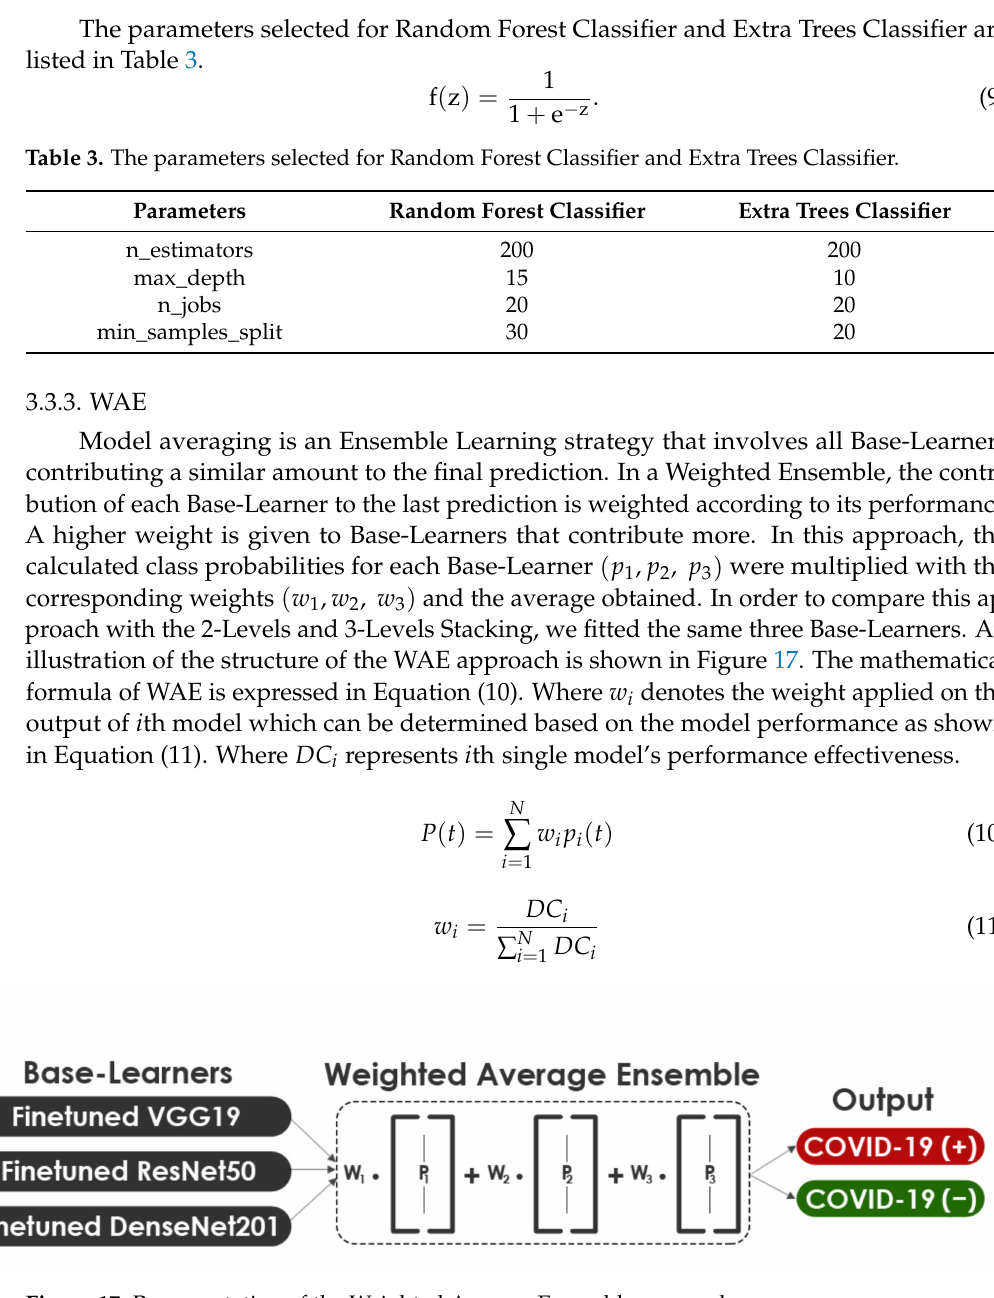
Figure 17. Representation of the Weighted Average Ensemble